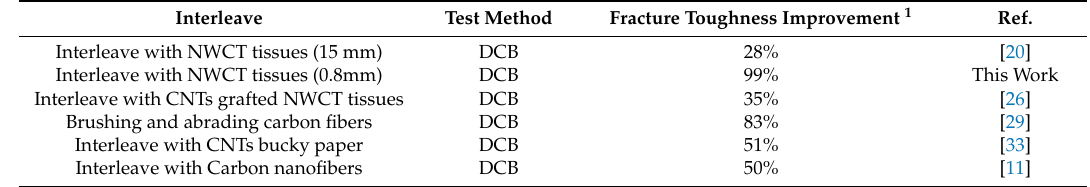
Table 1. Improvements in Mode I fracture toughness of CFRP composites with carbon interleaves.